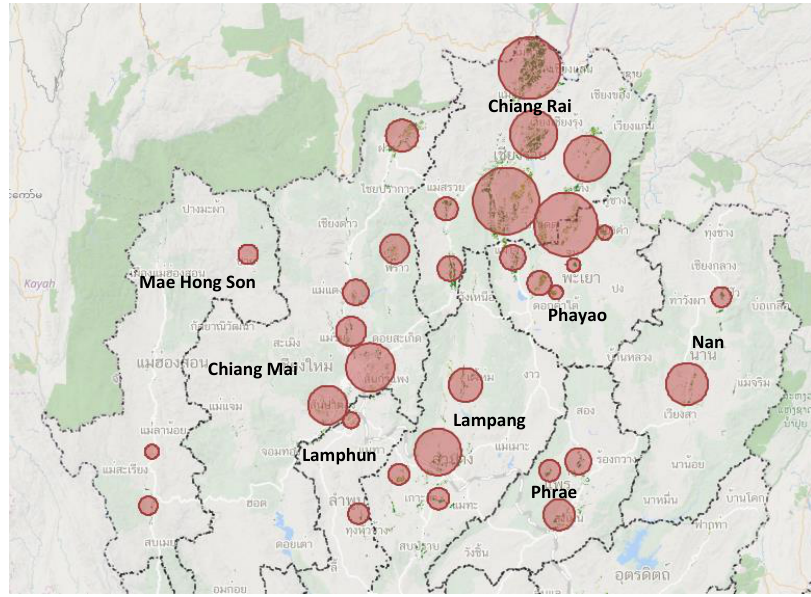
Figure 1. Planting area (red circles) in northern Thailand (gistdat.or.th).